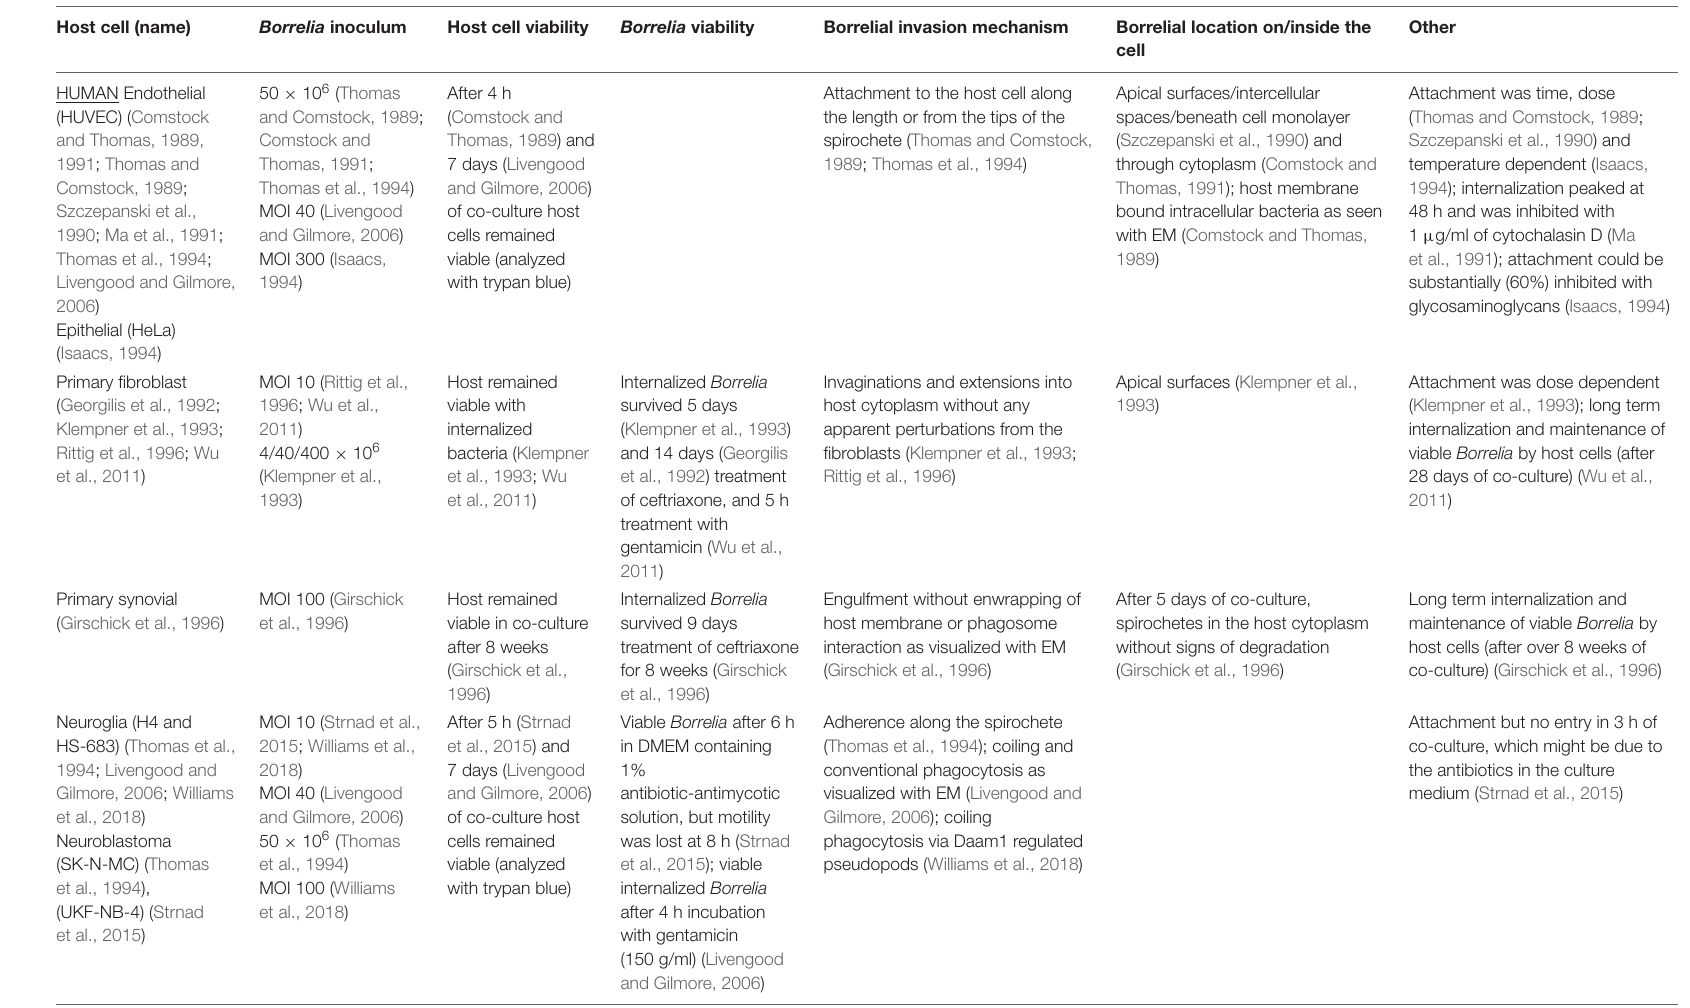
TABLE 3 | Synopsis of previous studies of borrelial infections in a variety of mammalian cell